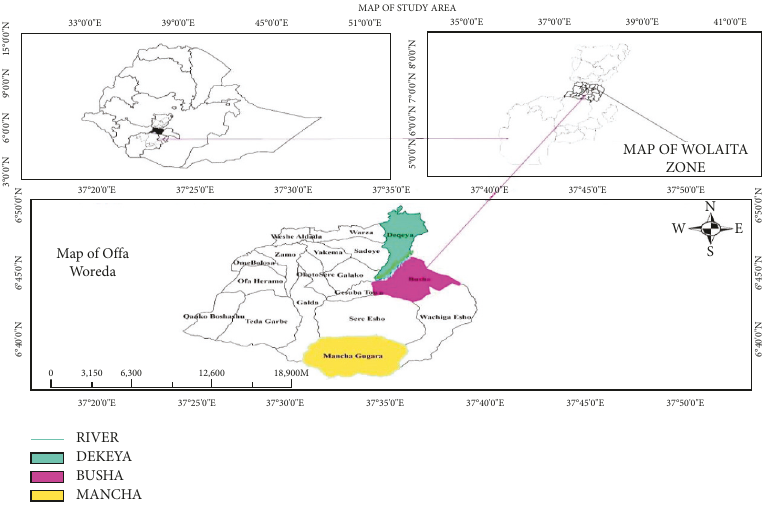
Figure 1: Map of the study area.